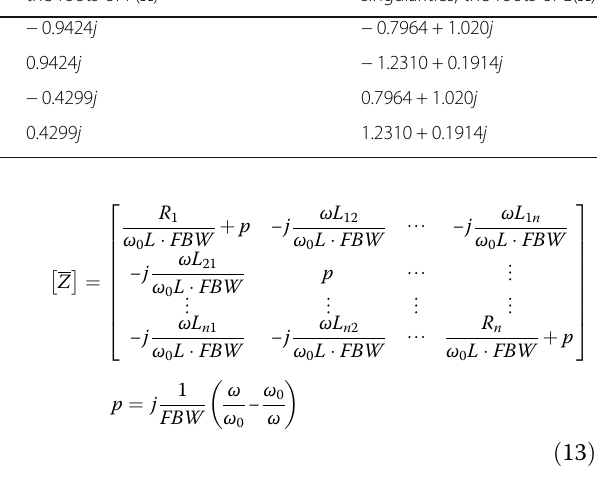
the roots of P ( Ω )